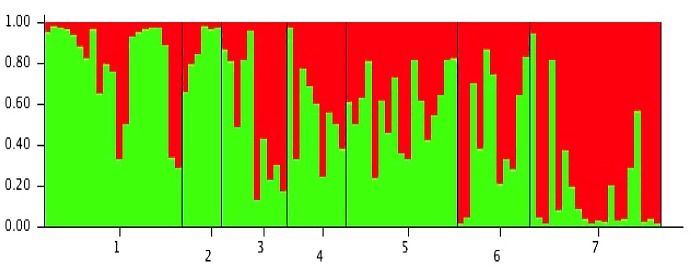
Culicoides brevitarsis population structure as inferred from nuDNA (EPIC-PCR and microsatellite DNA) markers using STRUCTURE 2.3.Culicoides brevitarsis population structure as inferred using the Bayesian clustering algorithm implemented in the program STRUCTURE 2.3 [71], based on nuclear DNA (four EPIC and two microsatellite) markers. Bar graphs are from K = 2 from 50,000 burn-in cycles and 500,000 runs. Populations are numbered from northern to southern regions, and combining (Kalumburu A and B (WA)) as one population (1), Douglas-Daly (2) and Katherine (3) from NT, and Lismore (4), Grafton (5), Bellingen (6), and Paterson (7) from NSW.